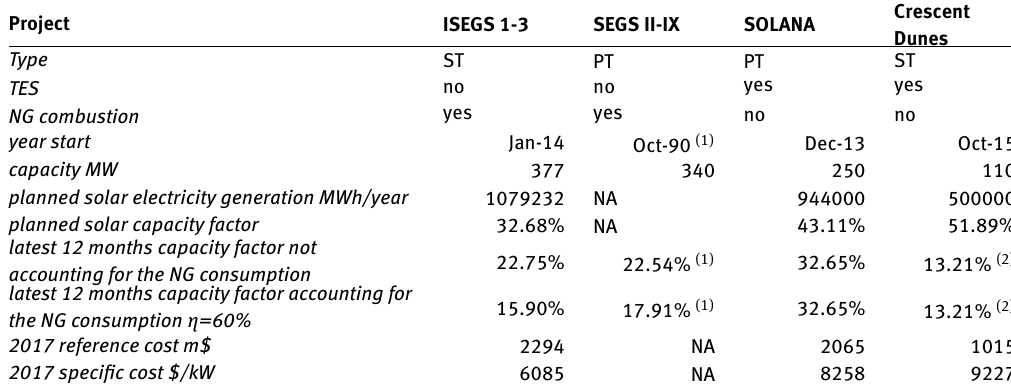
Table 2: Actual costs and performances of the ISEGS, SEGS, Solana and Crescent Dunes plants. Notes: (1) SEGS IX only. (2) January to Octo- ber